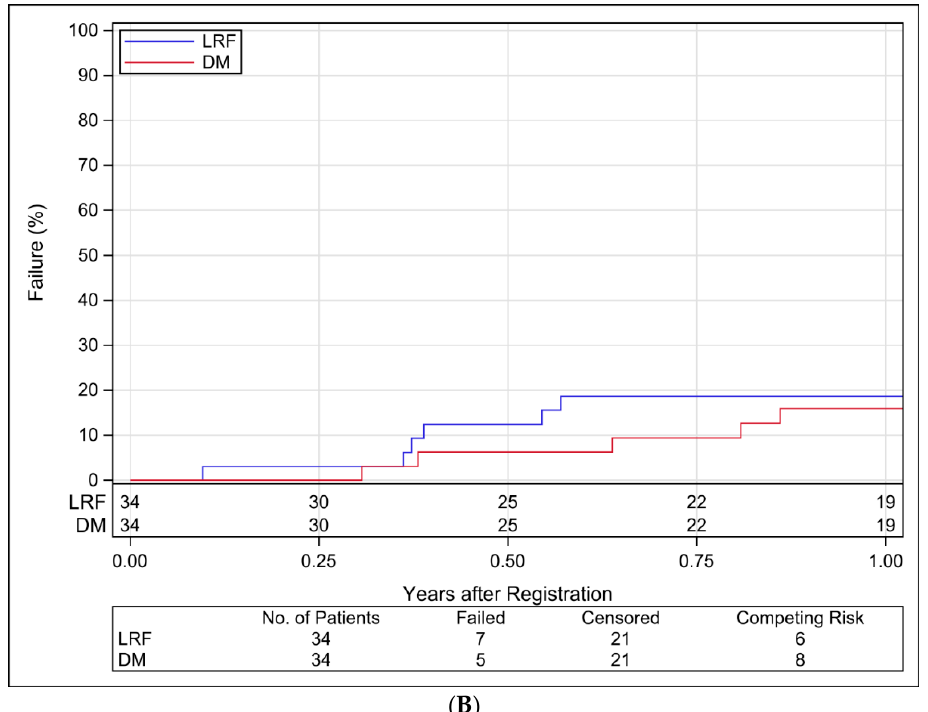
Figure 1. ( A ). Kaplan–Meier Estimates of Disease-Free and Overall Survival for Analyzable Patients in NRG-HN003. ( B ). Cumulative Incidence Estimates of Local-Regional Failure and Distant Metastasis for Analyzable Patients in NRG-HN003.